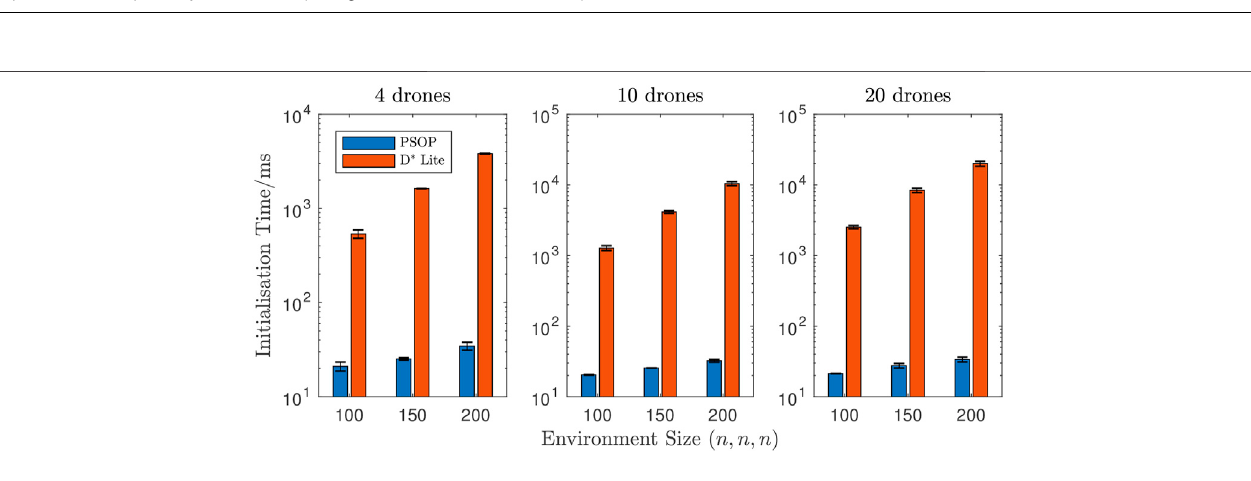
Frontiers in Applied Mathematics and Statistics |